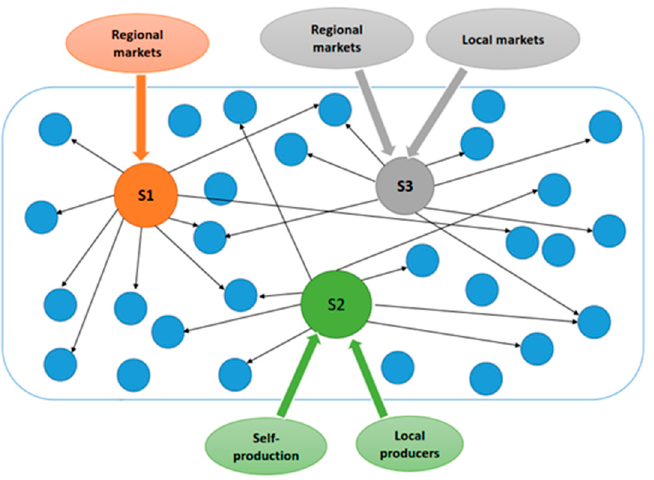
Figure 2. An illustration of temporarily reconfigured commodity networks in Norwind village.